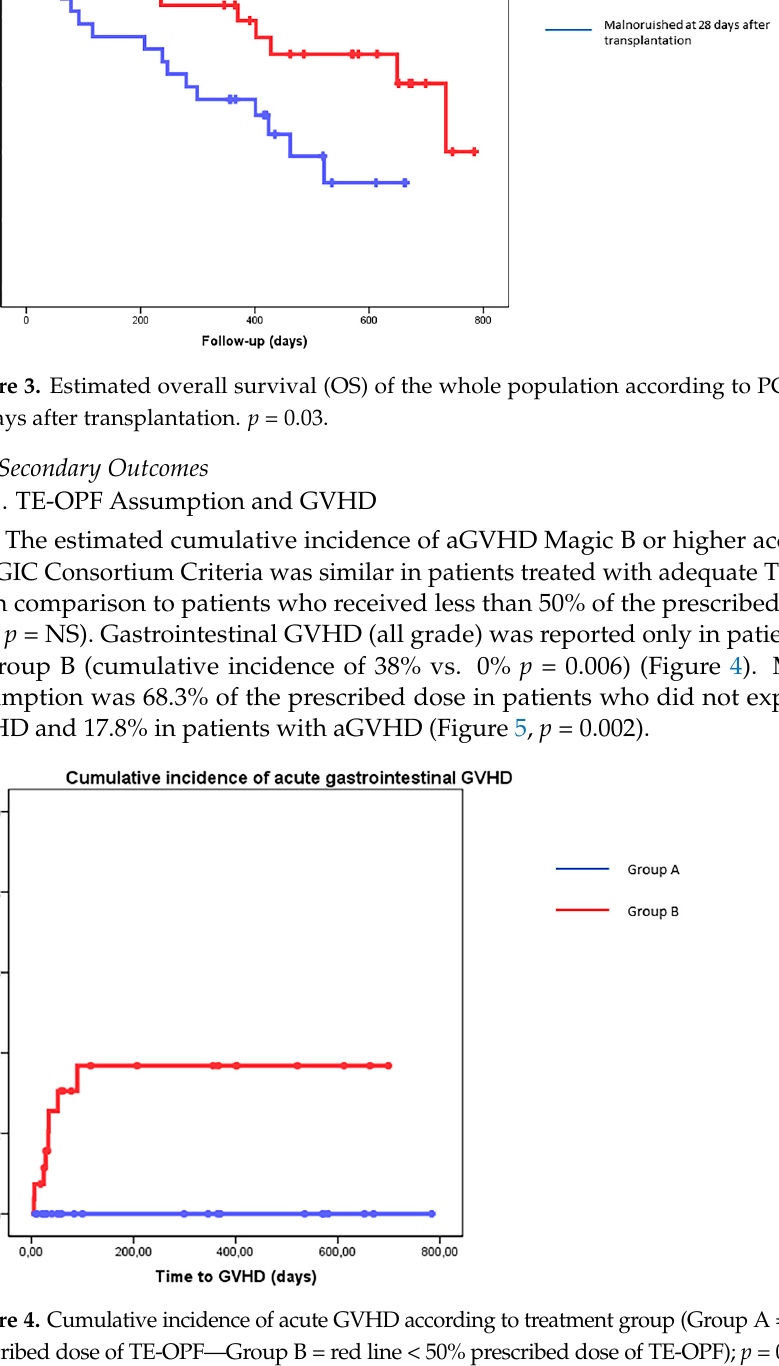
Figure 2. Mean TE-OPF assumption and malnutrition categories according to PG-SGA at 28 days